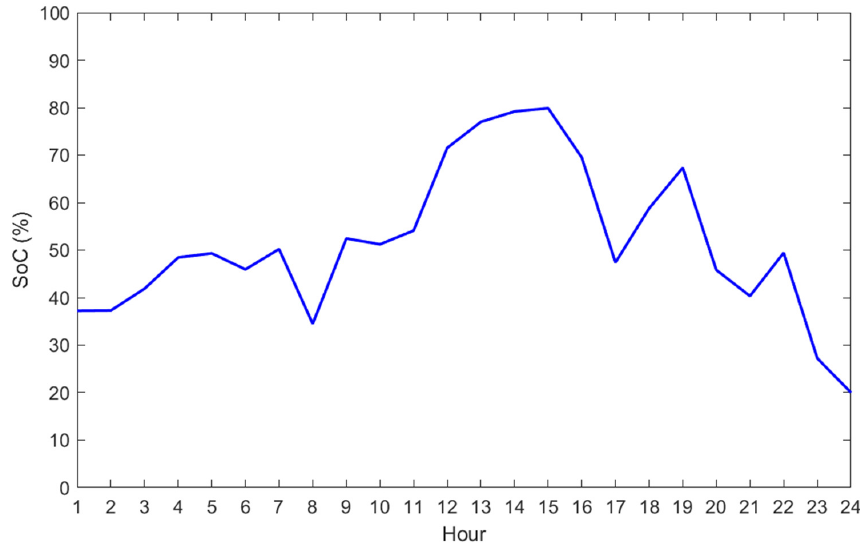
Figure 8. The SoC of ESS after solving the optimal scheduling of ESS by the DE algorithm for case 1.